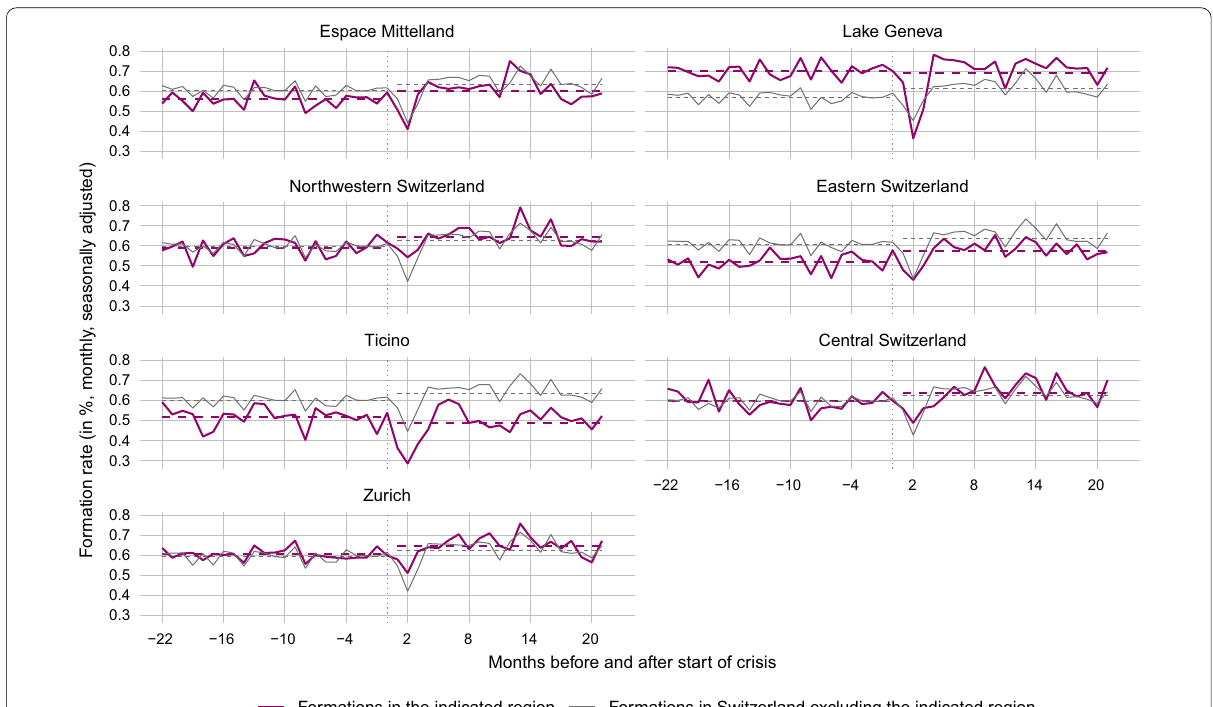
monthly seasonally = month 0) is February 2020. The =